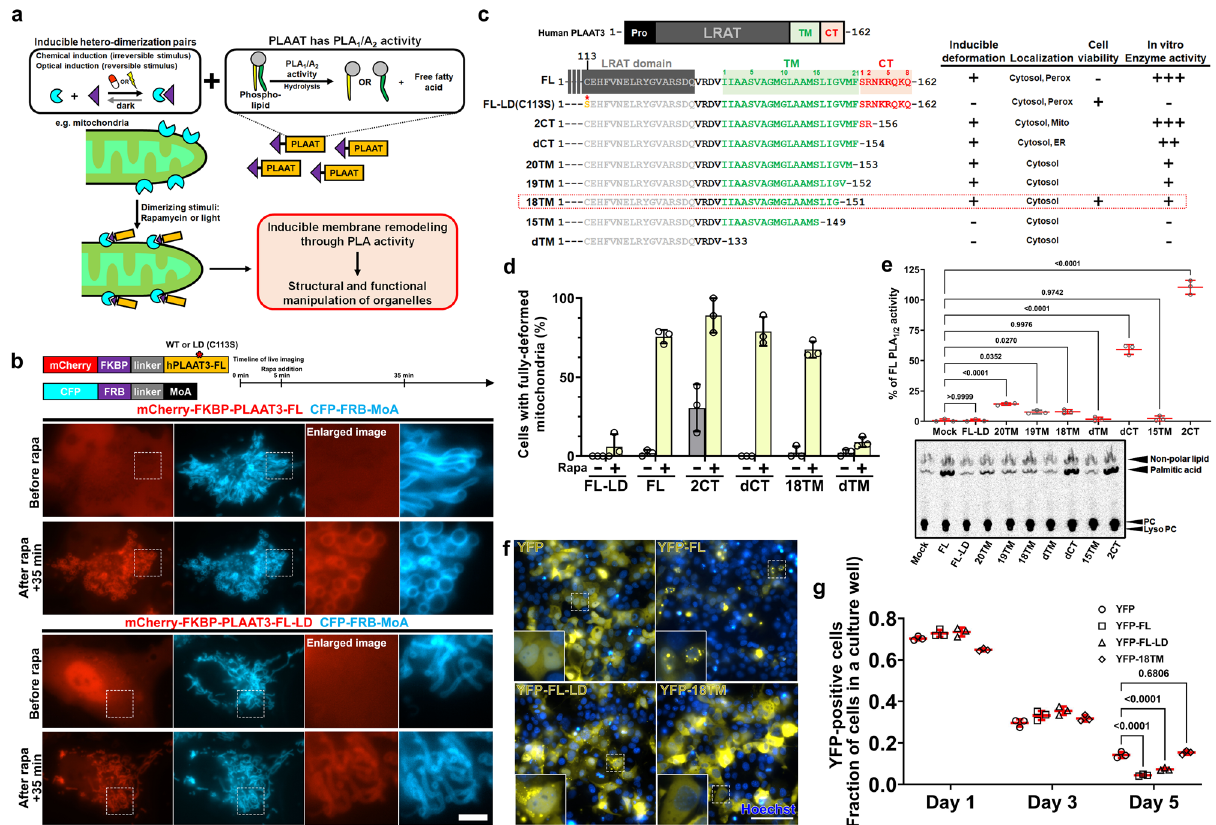
Fig. 1| InduciblemitochondrialmanipulationbyPLAAT3 anditsoptimization. a A conceptual schema describing rapidly inducible manipulation of intracel- lular organelles based on the integration of chemically or optically triggered hetero-dimerization and phospholipid remodeling by PLAAT enzymes. This strategy anticipates rapid switching of the PLAAT activity right at the target membrane-boundorganelles(e.g.,mitochondria)toinducetheirdeformationas well as defunctionalization. b Fluorescence images of COS-7 cells expressing CFP-FRB-MoA along with either mCherry-FKBP-PLAAT3-FL or mCherry-FKBP- PLAAT3-FL-LD before and 35min after addition of 100nM rapamycin. Experi- mental timeline and schematic drawing of constructs are shown on top. The experiment was repeated more than three times. c A summary of PLAAT3 domain structures (top), as well as C-terminal sequences of full-length PLAAT3 along with its LD and a series of truncation mutants (bottom) and their prop- erties.18TMwasusedasatoolinthelaterexperiments.Pro:proline-richdomain, LRAT: Lecithin-retinol acyltransferase domain, TM: putative transmembrane domain, CT: C-terminus domain, FL: full length of hPLAAT3, LD: lipase-dead